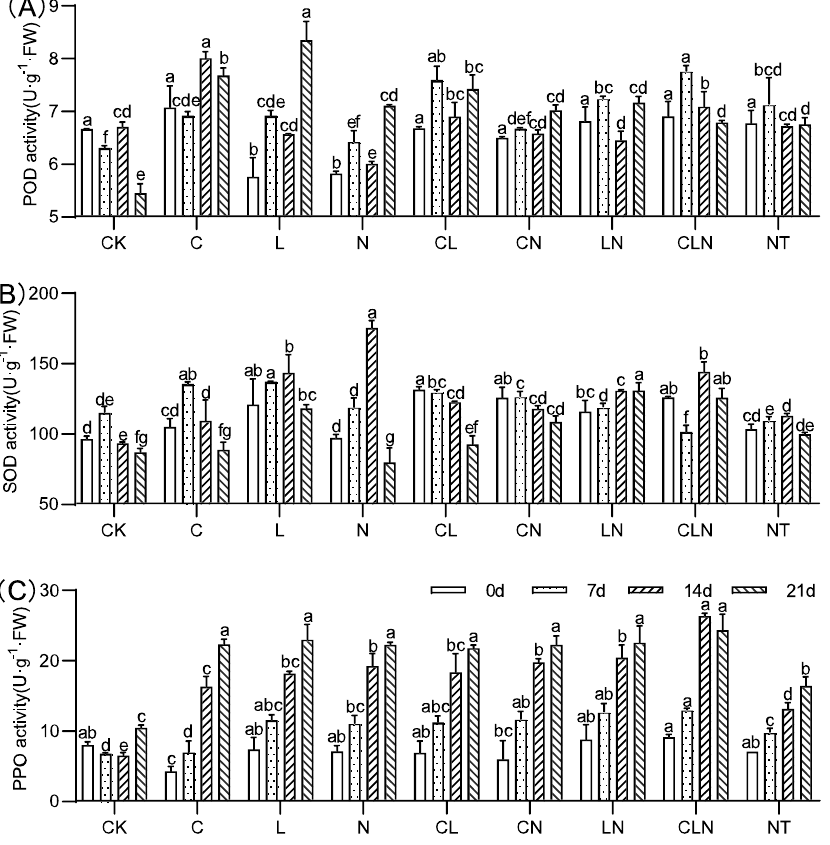
Figure 3. POD ( A ), SOD ( B ) and PPO ( C ) activity under treatments at seedling stage in papaya. Whereas CK—control without the use of bio-pesticides, C—use of 0.50 g L − 1 Chitosan, L—use of 10.00 g L − 1 Lentinan, N—use of 0.05 g L − 1 Ningnanmycin, CL—Chitosan plus Lentinan, CN—Chitosan plus Ningnanmycin, LN—Lentinan plus Ningnanmycin, CLN—Chitosan plus Lentinan plus Ningnanmycin. All the above treatments were applied by means of root irrigation with 200 mL, foliar spraying with 200 mL, and then inoculated with PRSV virus. NT—negative control without PRSV inoculation. Different lowercase letters indicate significant differences at the 0.05 level. Table 2. Effect of C, N and L on POD, SOD and PPO activity during Pot and Field experiment. Field Experiment